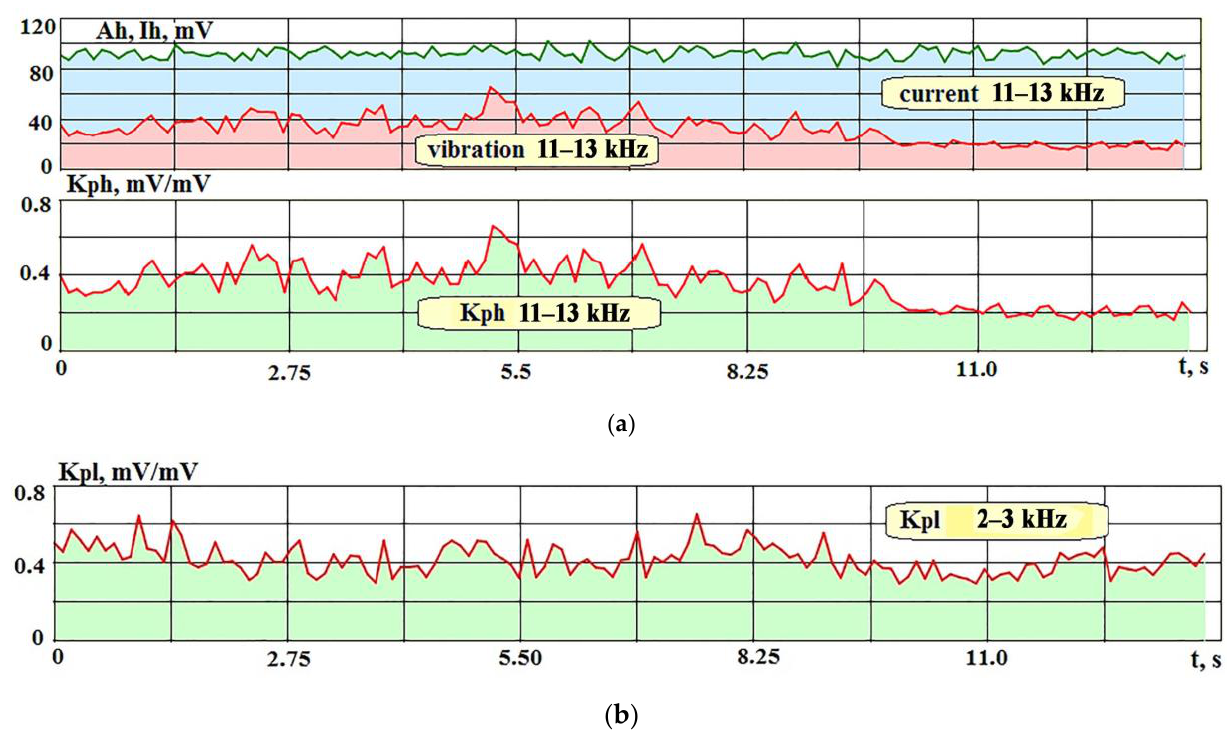
Figure 10. Changes in the transmission coefficients at high and low frequencies from the moment of embedding to the break of the wire electrode during repeated cutting of the hard alloy HG012: ( a ) — RMS of vibration amplitudes, current, and transmission coefficient Kph for the range 11 – 13 kHz; ( b ) — change in the Kpl coefficient for the range 2 – 3 kHz.